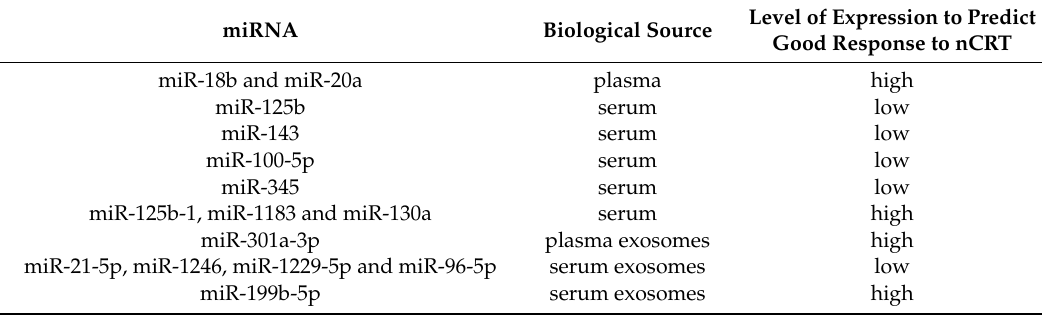
Level of Expression to Predict Good Response to nCRT